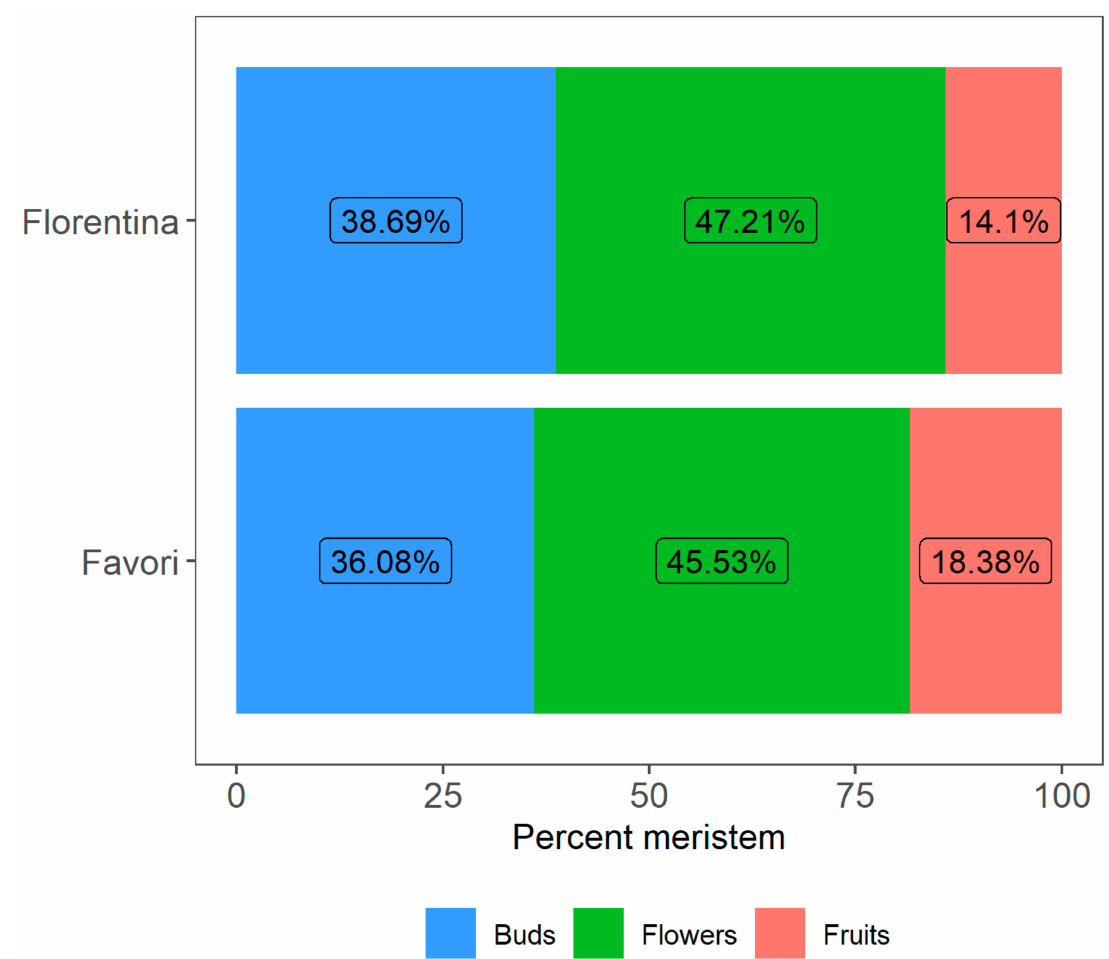
Figure 11. Percentage of meristems that differentiated into flowers and fruits for plants of the strawberry cultivars ‘Florentina’ and ‘Favori’ after 14 weeks at 20 ◦ C under LD conditions. The buds that were below S9 (fully differentiated flower) were compiled as